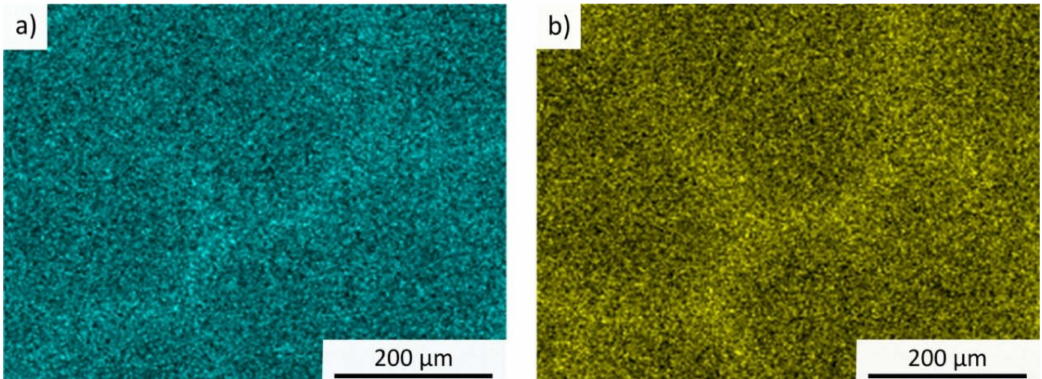
Figure 3. Results of X-ray elemental mapping for initial state of the material (K-alpha lines). ( a ) Manganese segregations; ( b ) chromium